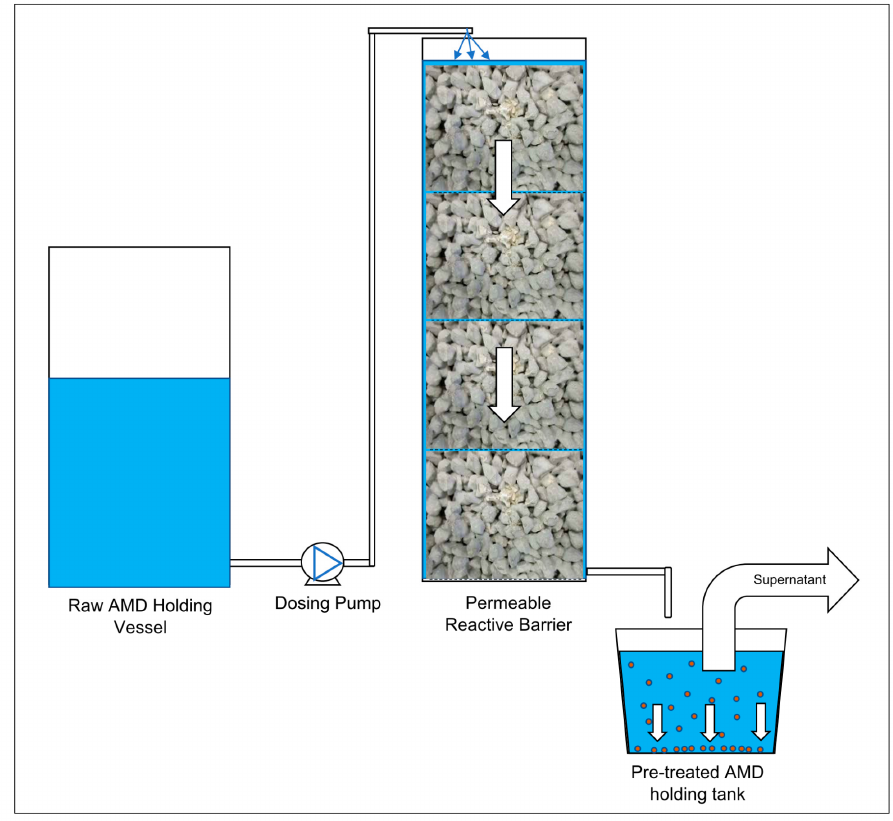
Figure 1. Permeable reactive barrier